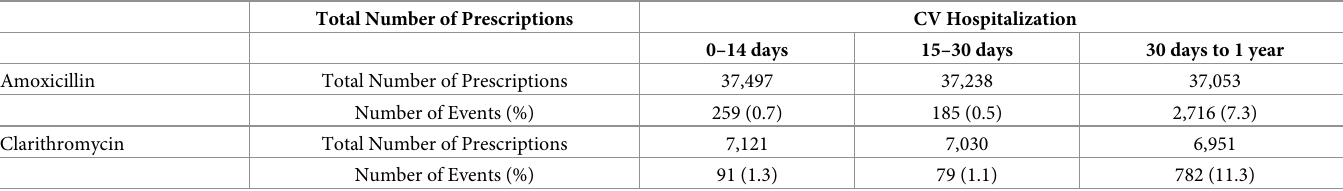
Table 5. Cardiovascular events in the pharmacogenomic cohort study.